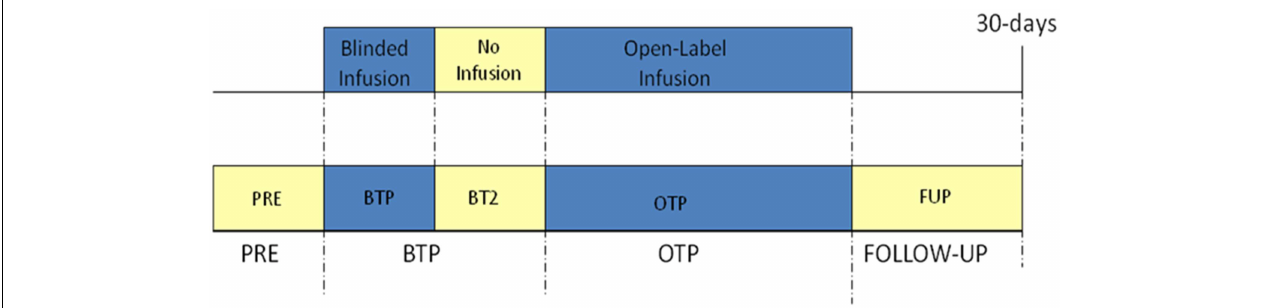
FIGURE 1 | Schematic of study flow. PRE, pre-study drug administration period; BTP, blinded treatment phase; BT2, blinded treatment phase II; OTP, open-label treatment phase. See manuscript text for description of each phase.